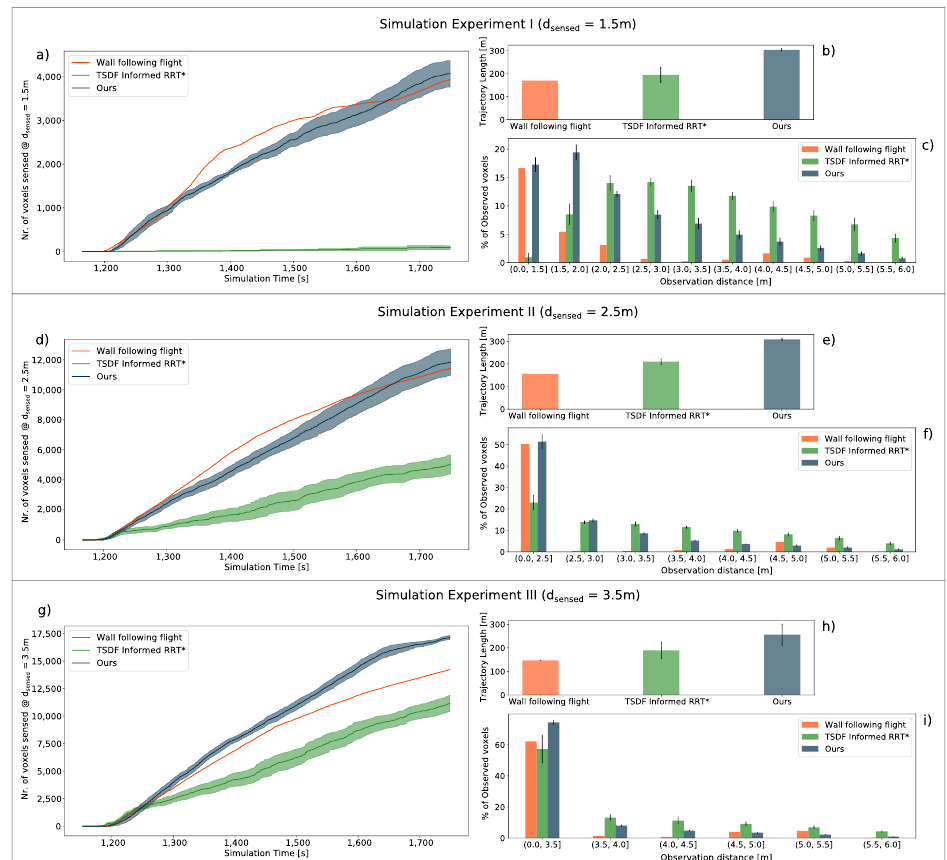
Figure 7. Simulation experiment results for the three different values of d sensed . For each simulation scenario: ( a , d , g ) number of voxels sensed along the inspection path for the three methods compared, ( b , e , h ) mean length and standard deviation of the inspection trajectory, ( c , f , i ) mean distance distribu- tion of all the voxels observed during the inspection. These results correspond to 10 simulation runs for each experiment.